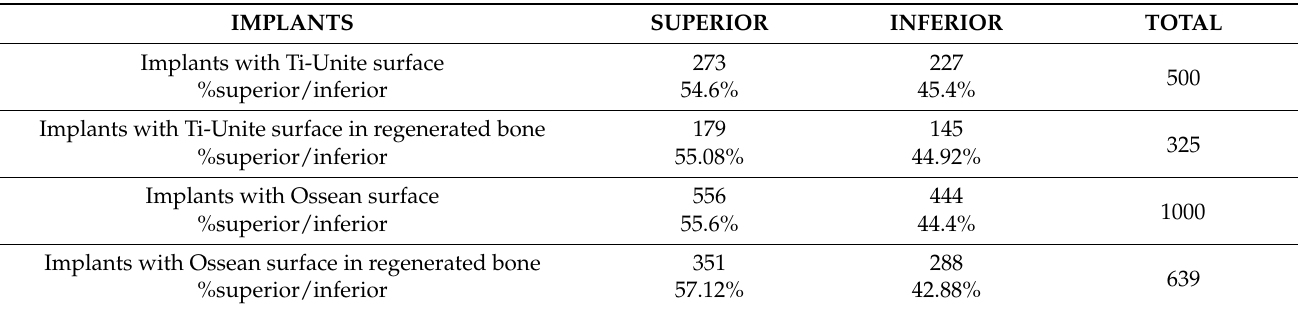
Table 1. Number of implants with Ti-Unite surface and Ossean surface, both in pristine and regenerated bone. IMPLANTS Implants with Ti-Unite surface